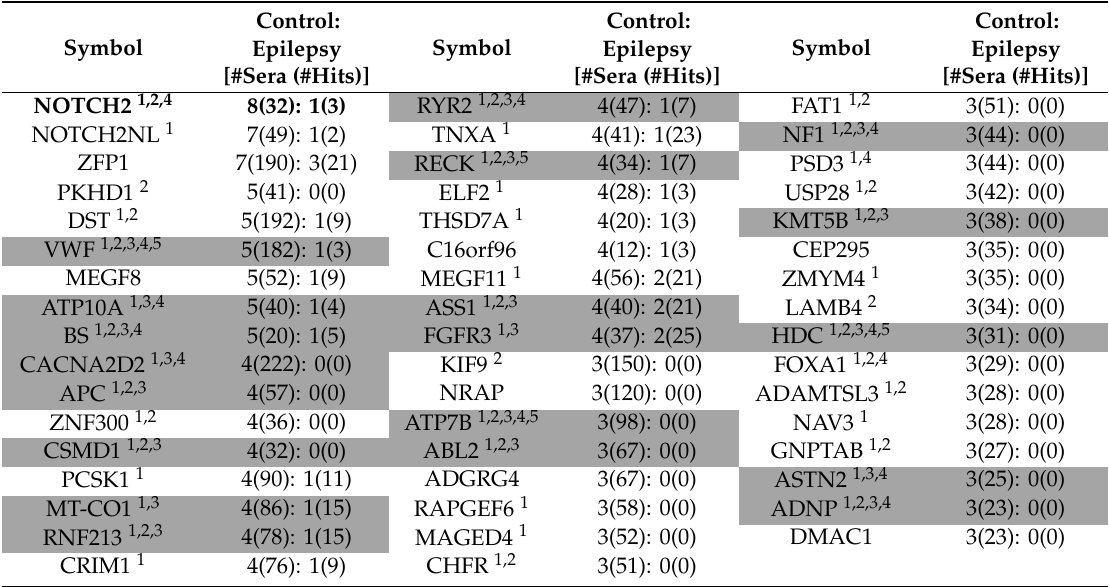
1 neurological; 2 immune / inflammation; 3 seizure / epilepsy related (shaded); 4 ion-channel related; 5 blood–brain barrier